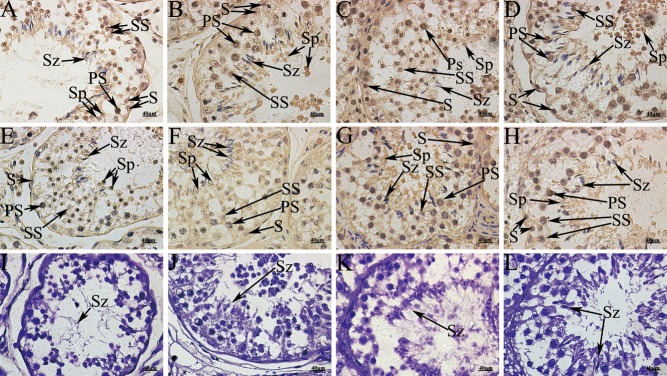
Immunohistochemistry with AGO2 and AGO3 using the immunoperoxidase method and hematoxylin counterstain from yak testis during postnatal development. (A, B, C and D) Expression of AGO2. (E, F, G and H) Expression of AGO3. (I, J, K and L) Negative control. (A, E and I) age <2 years; (B, F and J) 2 < age < 4 years; (C, G and K) 4 < age < 6 years; (D, H and L) 6 < age < 8 years. PS, primary spermatocytes; S, spermatogonia; Sp, spermatids; SS, secondary spermatocytes; Sz, spermatozoa.